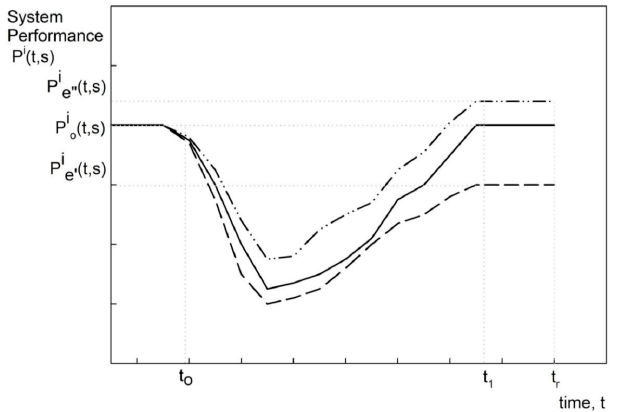
Figure 5. Various responses of system performance to a disturbance (partial recovery, recovery to pre ‐ hazard system performance, and strengthening of system performance) (adapted from Peck et al. [24]).